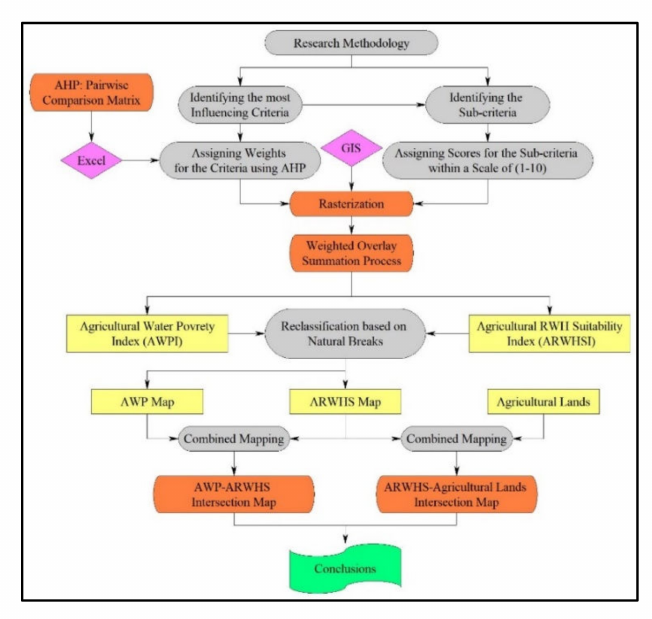
Figure 2. Research